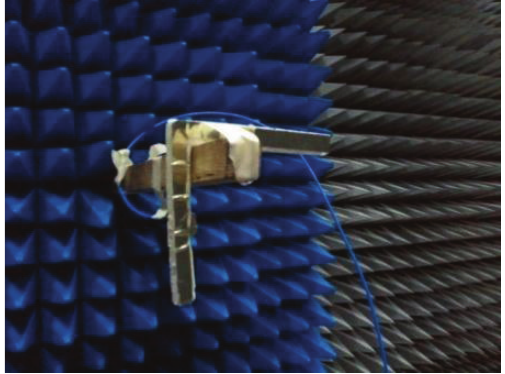
Figure 19: Antenna prototype mounted on the rotating platform for radiation pattern